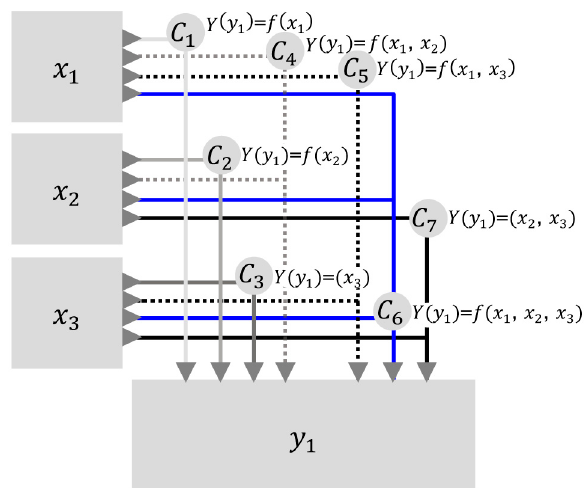
Figure 2. Graphical representation of the M-DEA model from the theoretical formulation of Stosic and Fittipaldi [35]. Source: Author’s own elaboration based on Stosic and Fittipaldi [35].